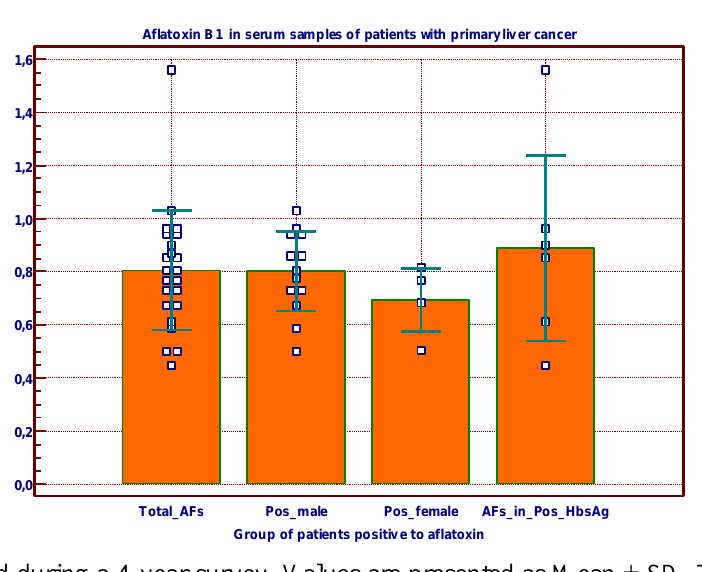
Figure 2. AFB content µg·L -1 in serum of primary liver cancer patients from Yaounde Hospital. 1 Aflatoxin B1 in serum samples of patients with primary liver cancer